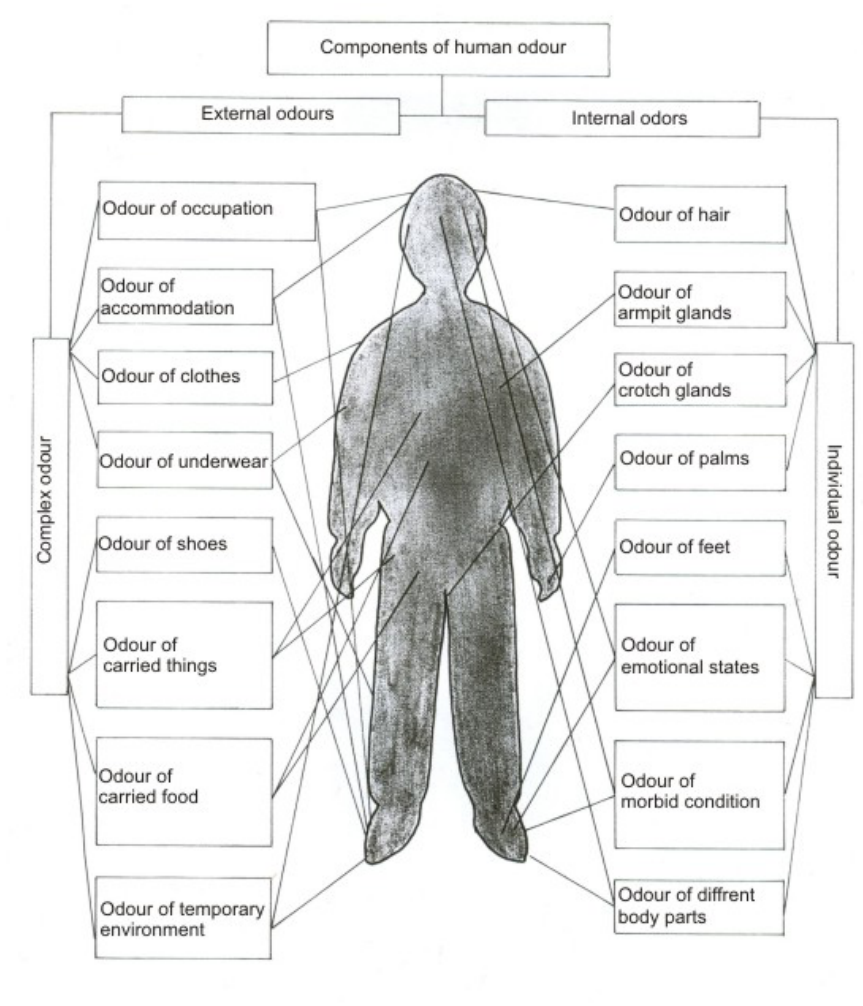
Fig. 4. The structure of human scent, source: (cid:224)achacz 1998, p.